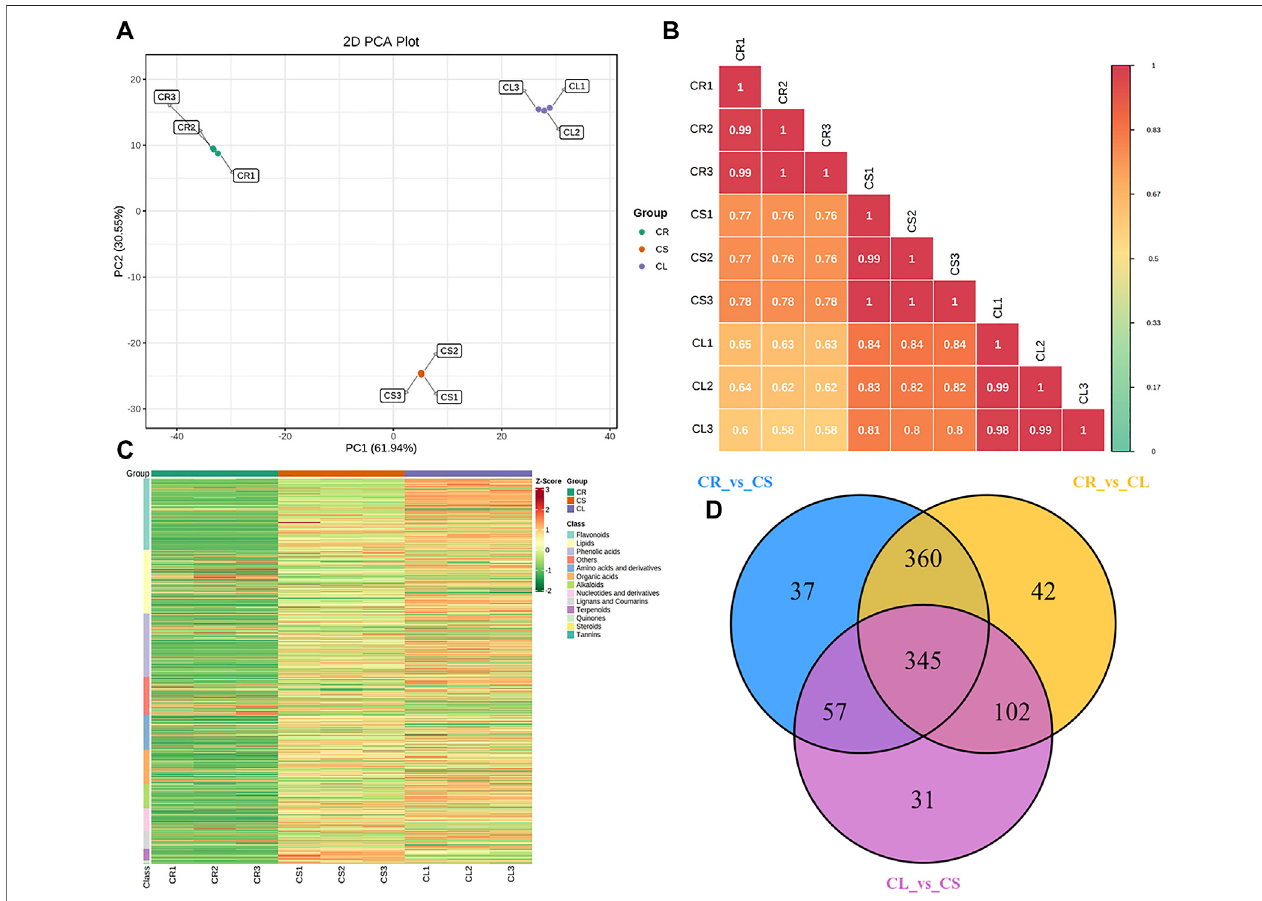
FIGURE 1 | Metabolome analysis of tuber, stem, and leaves of C. convolvulacea. (A) Principal component analysis, (B) Pearson ’ s correlation coef fi cient, (C) heatmap of the metabolite concentrations and their classi fi cation, and (D) venn diagram representing the number of metabolites that were differentially accumulated in the three comparisons. CS, CL, and CR represent stem, leaf, and tuber,